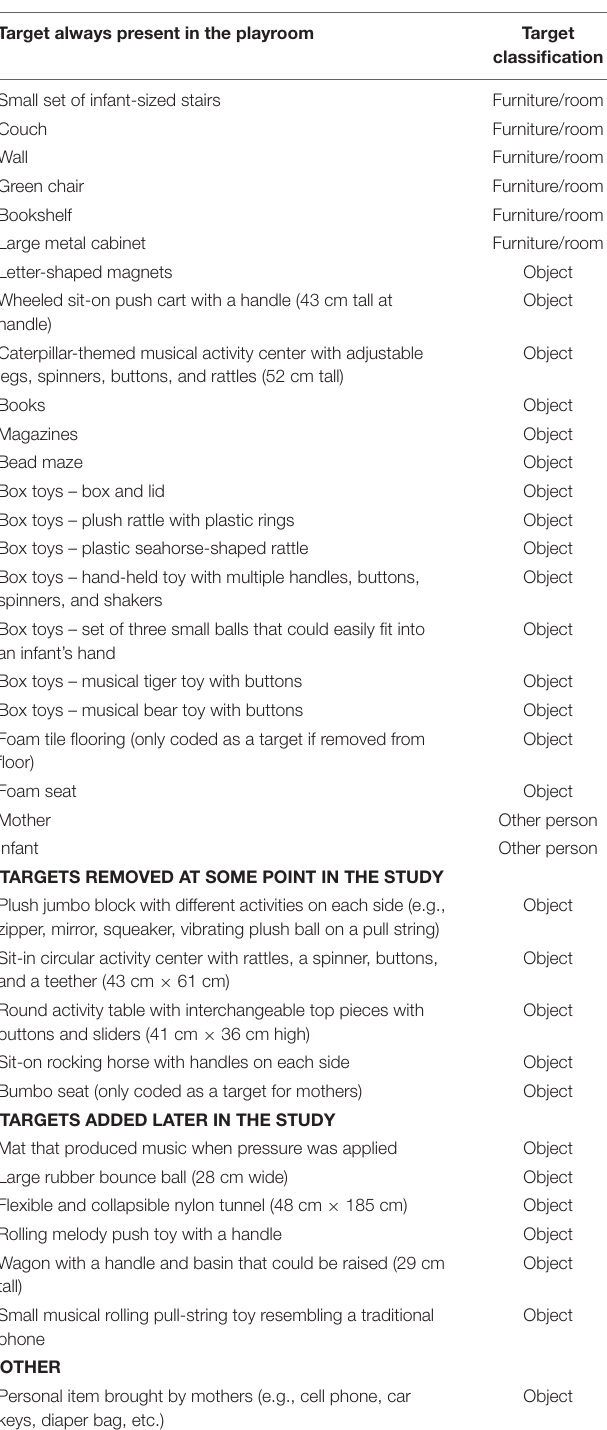
TABLE 2 | List of all targets used in study, their classifications, and the length of time they were available in the playroom. Target always present in the